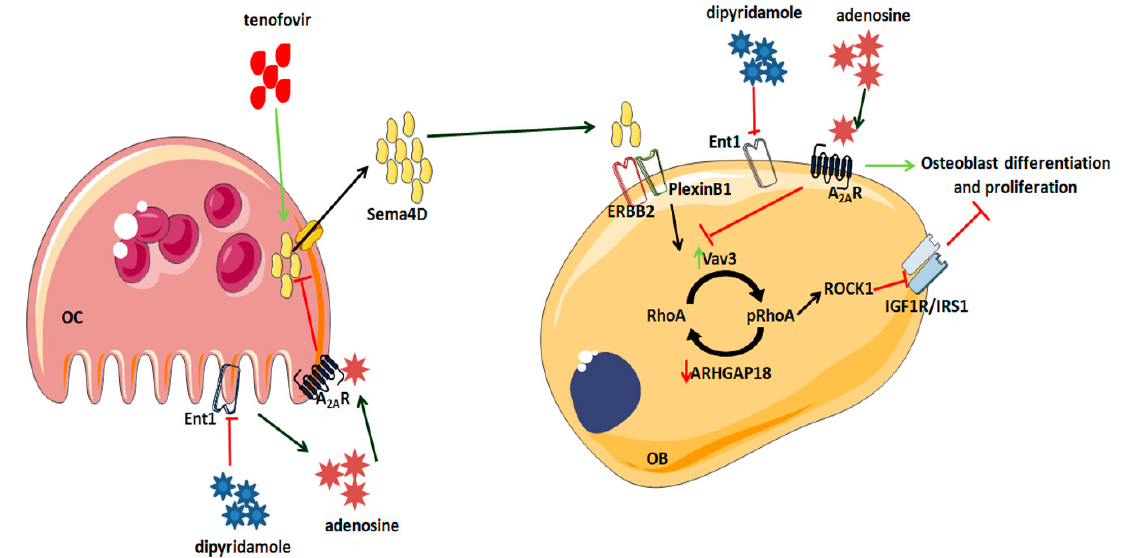
Figure 9. Proposed pathway for tenofovir and Sema4D. Tenofovir promotes Sema4D secretion from osteoclast, and activation of PlexinB1 in osteoblast, activation of RhoA phosphorylation and ROCK1 activation and inhibition of IGF1R/IRS1. Treatment with compounds that increase extracellular adenosine levels, such as dipyridamole, can revert this effect. OC: osteoclast; OB: osteoblast, A2AR: adenosine A2A receptor: Ent1: Equilibrative nucleoside transporter1; Sema 4D: Semaphorin 4D; ERBB2: receptor tyrosine-protein kinase erbB-2. Vav3:Vav Guanine Nucleotide Exchange Factor 3: ARHGAP18: Rho GTPase Activating Protein 18. IGF1: insulin-like growth factor-1; IRS1: Insulin receptor substrate 1 .